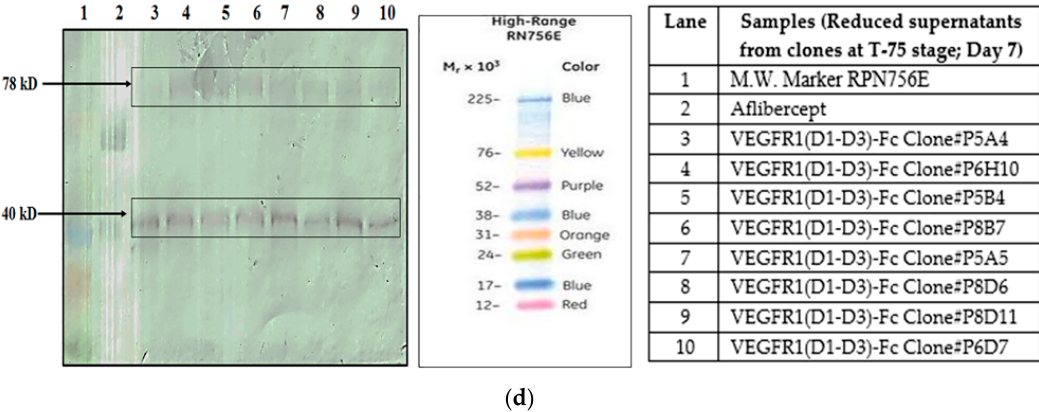
Figure 1. ( a ) Western Blot of supernatants of transfected HEK293T cells expressing VEGFR1(D1-D3)-Fc protein at different time points in 24-well plate; ( b ) Western Blot for VEGFR1-Fc detection in supernatants of transfected CHOK1SV GS-KO clones at 24-well plate stage of clone development; ( c ) Western Blot of supernatants of clones at T-25 stage for VEGFR1(D1–D3)-Fc protein expression analysis; ( d ) Western Blot of supernatants of clones at T-75 stage for VEGFR1(D1–D3)-Fc protein expression analysis.